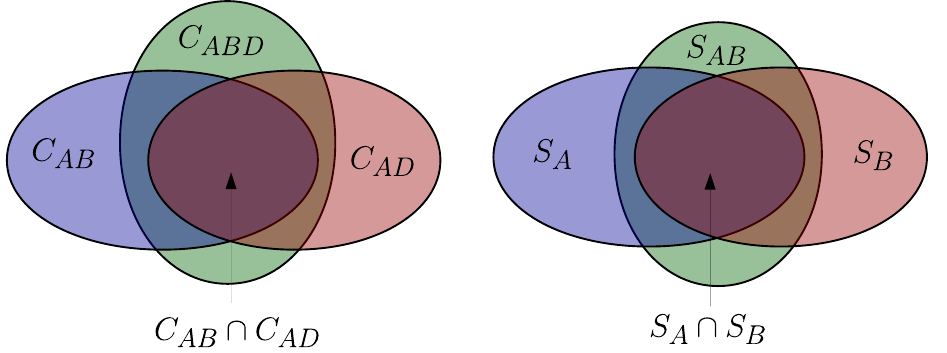
Figure 5 . The picture illustrates the identities S A \ S B (cid:26) S AB (right) and C AB \ C AD (cid:26) C ABD (left).